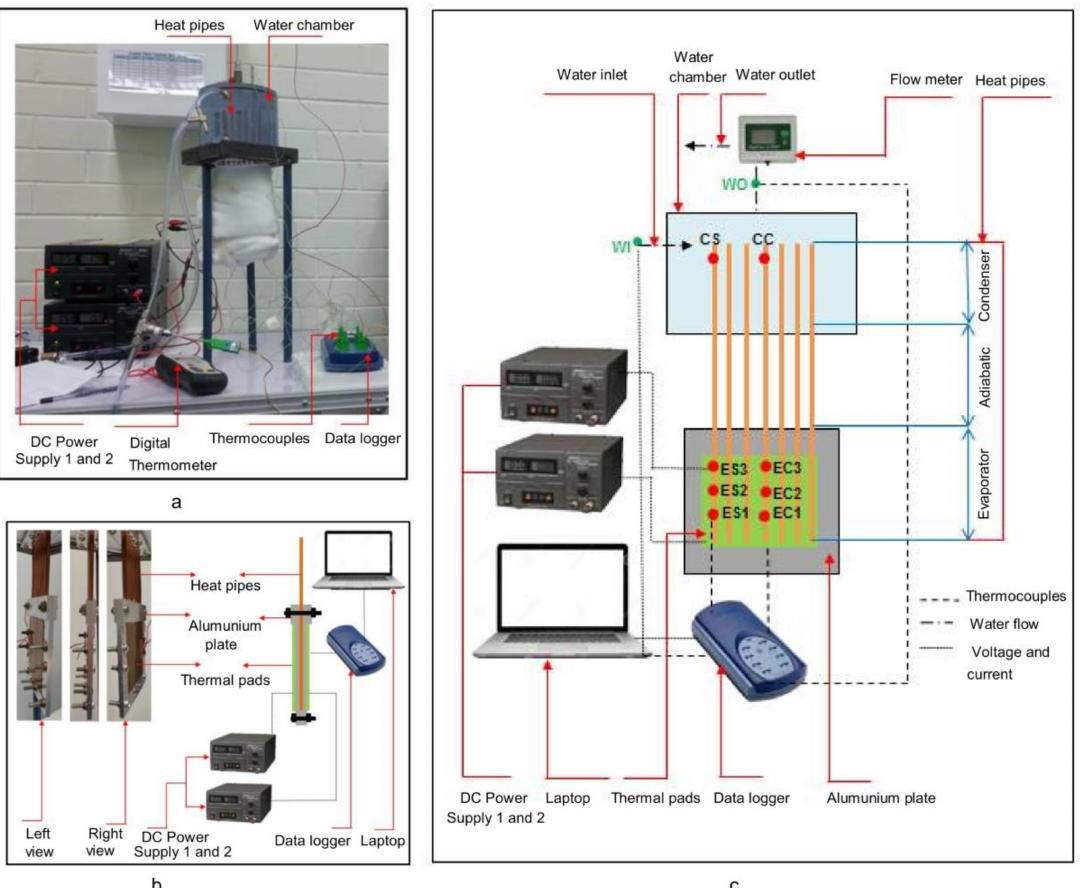
Figure 1. ( a ) The experimental set-up comprising of a water chamber, seven heat pipes, aluminum plates (for mimicking the cooling plate of a 100 W PEMFC), and thermal pads generating 20% of the total fuel cell cooling load (that is equivalent to the heat demanded by one MH canister); ( b ) The side view of the aluminum plates and the thermal pads used to mimic the fuel cell side and ( c ) Schematic diagram of the experimental set-up shown in Figure